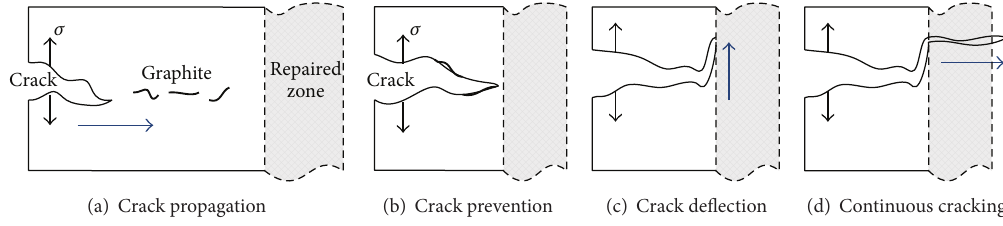
Figure 13: Cracking model of repaired